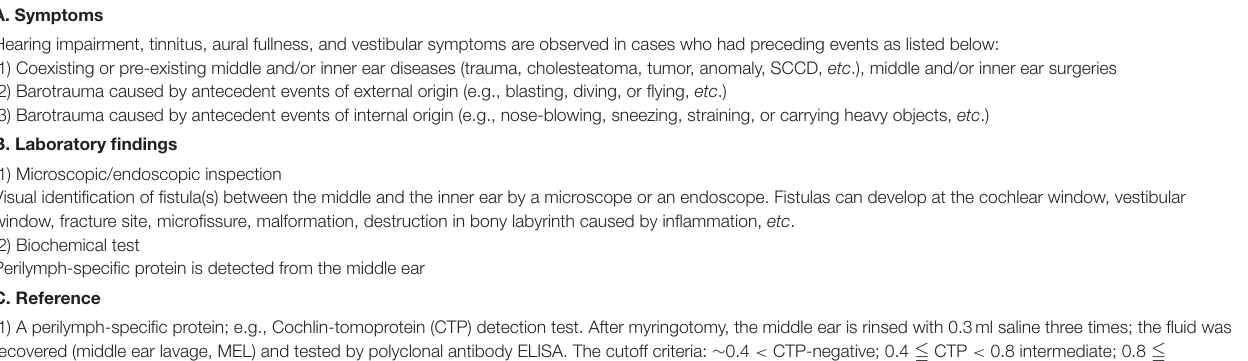
TABLE 1 | Diagnostic criteria for perilymph fistula (PLF) (based on the criteria of the Intractable Hearing Loss Research Committee of the Ministry of Health and Welfare, Japan revised in